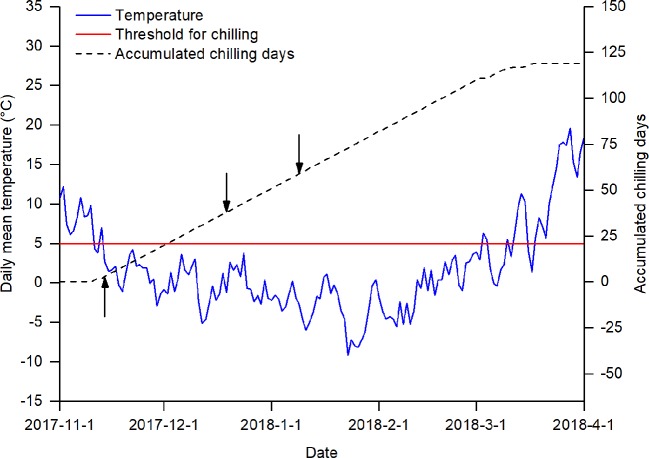
Daily mean temperature and accumulated chilling days from 1 November 2017 to 1 April 2018. The arrows indicate the three sampling dates. The red line indicates the threshold for accumulating chilling days.